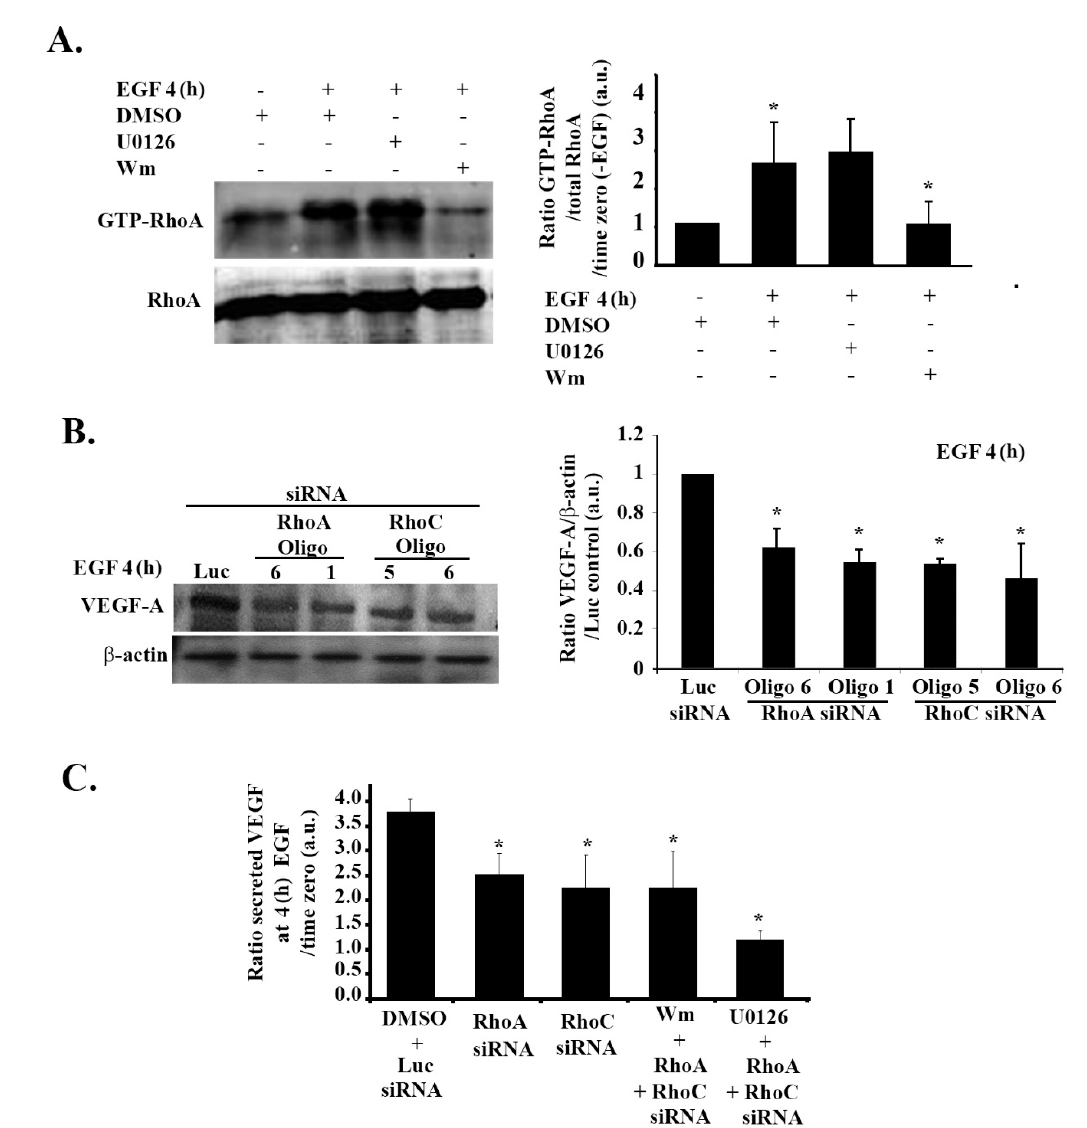
Figure 6. RhoA and RhoC mediate PI3K-regulated increase in VEGF expression and secretion in response to EGF stimulation in glioblastoma cells. ( A ) ( + indicates addition of the treatment) SF-268 cells were starved in serum-free media, then stimulated with 15 nM EGF for 4 h and treated with DMSO alone, U0126 (50 µ M), or Wm (100 nM) (treatment sequence explained in Section 2). The lysates were then subjected to a RhoA pull-down assay. The upper gel shows the active (GTP-loaded) RhoA that was pulled down with the GST-RBD beads blotted with anti-RhoA, and the lower gel shows the total lysates blotted for anti-RhoA for loading control. The graph is a quantitation of the bands in the upper gel normalized to total RhoA and expressed as fold change compared to time zero ( − EGF). ( B ) SF-268 cells were transfected with di ff erent siRNA oligos as indicated, starved, and stimulated with EGF for 4 h. Cells were then lysed, and cell lysates were blotted for VEGF-A or β -actin for loading control. The graphs are quantitations of the VEGF bands normalized to actin and expressed as fold change compared to control (luciferase siRNA). ( C ) ELISA for supernatants from SF-268 cells transfected with the indicated oligos, treated with DMSO, Wm, or U0126, then starved and stimulated with EGF for 4 h or left unstimulated and measured for VEGF-A secretion. Values are expressed as fold change compared to time zero ( − EGF). The data are means ± SEM from three di ff erent experiments ( n = 3); * p < 0.05 indicates statistically significant differences.